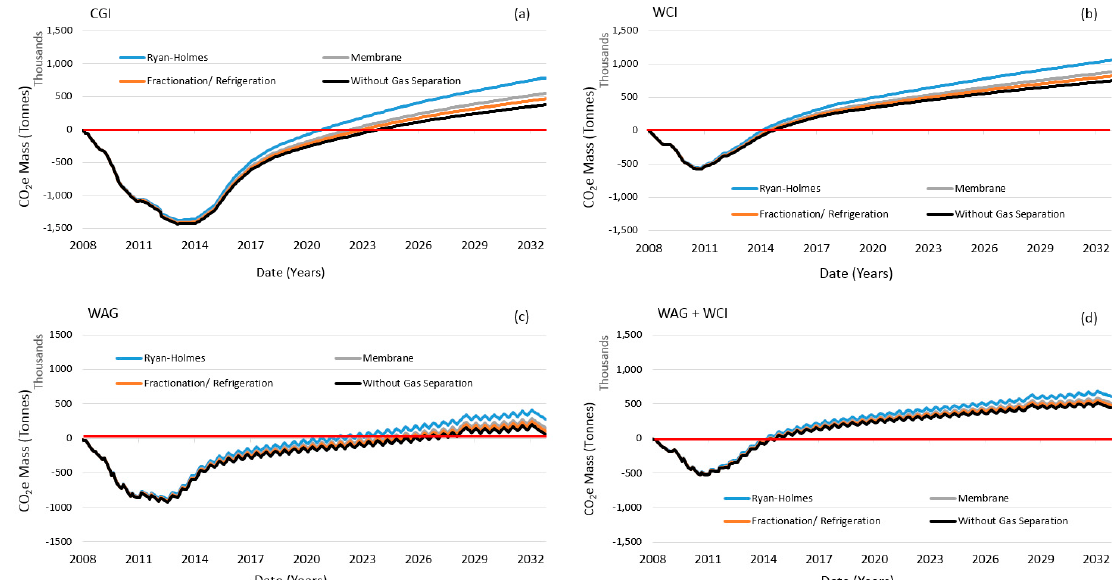
Figure 7. Carbon balance (CO 2 e emissions minus CO 2 storage) of the gate-to-grave CCUS system. ( a ) continuous gas injection, ( b ) water curtain injection, ( c ) water-alternating-gas, and ( d ) the hybrid scenario. Table 3. Important CCUS parameters at the transition point (CO 2 storage = CO 2 e emissions). Scenarios without stacked saline carbon storage.